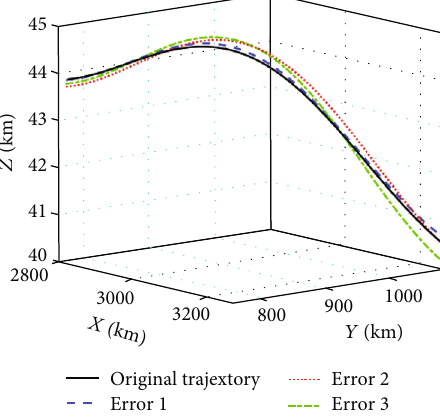
Figure 13: Predicted trajectory with di ff erent error of